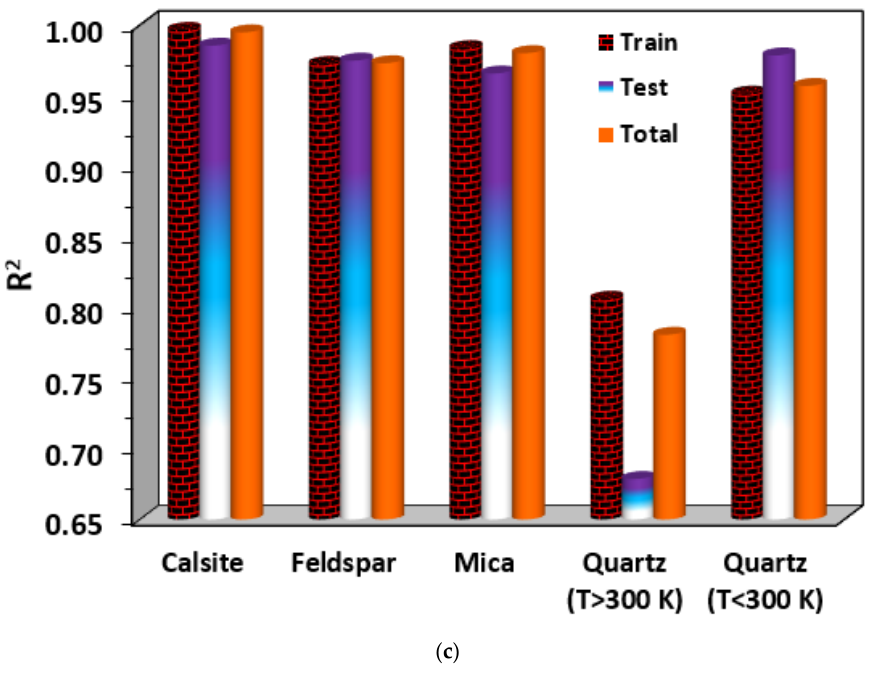
Figure 6. Comparison between different minerals in predicting contact angle. ( a ): Root mean square error (RMSE); ( b ): Average absolute percent relative error (AAPRE); ( c ): Coefficient of determination. Table 4. Statistical evaluation of the implemented